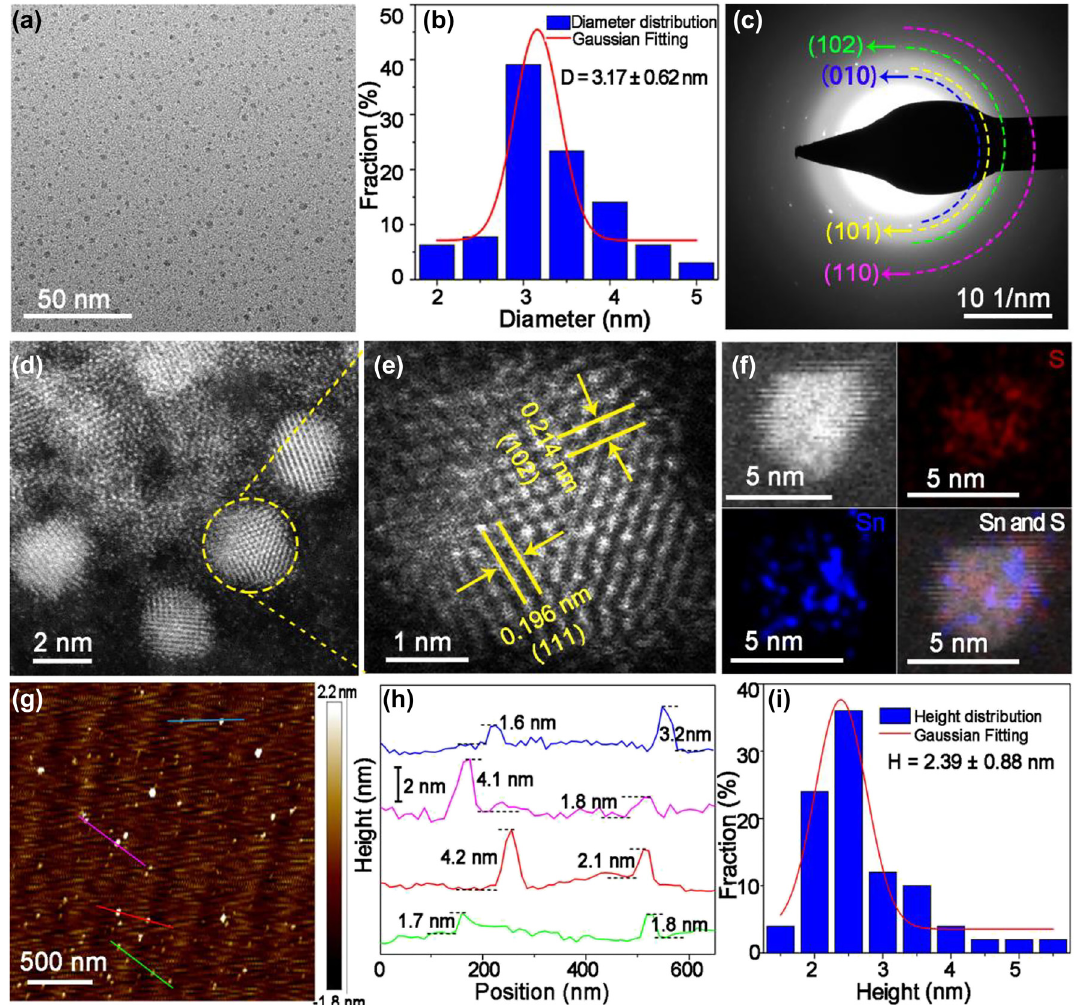
QDs. (a) TEM images of as-synthesized SnS QDs. (b) Lateral size distribution of SnS Figure 1: Morphology and characterizations of SnS 2 2 2 QDs. (c) Typical SAED image of SnS QDs. (d, e) HAADF-STEM image of SnS QDs. (f) Corresponding EDS mapping of SnS QDs. (g) AFM image 2 2 2 single crystal. (h) Thickness distribution of SnS QDs. (i) Vertical size distribution of SnS of a resultant SnS 2 2 2